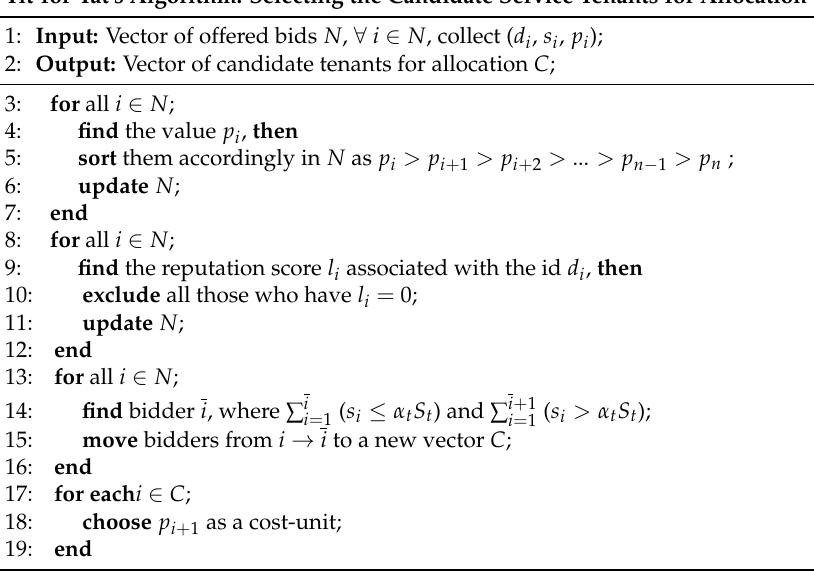
Table 2. Tit-for-Tat selection